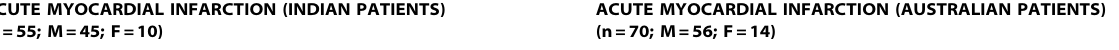
Table 1. Characterization of the acute myocardial infarction in patients selected for the